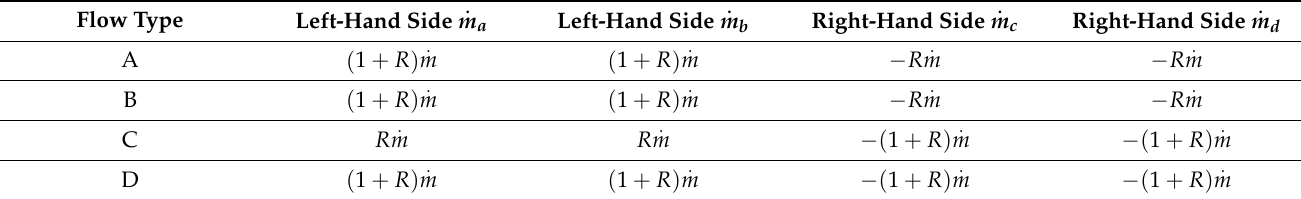
Flow Type Left-Hand Side